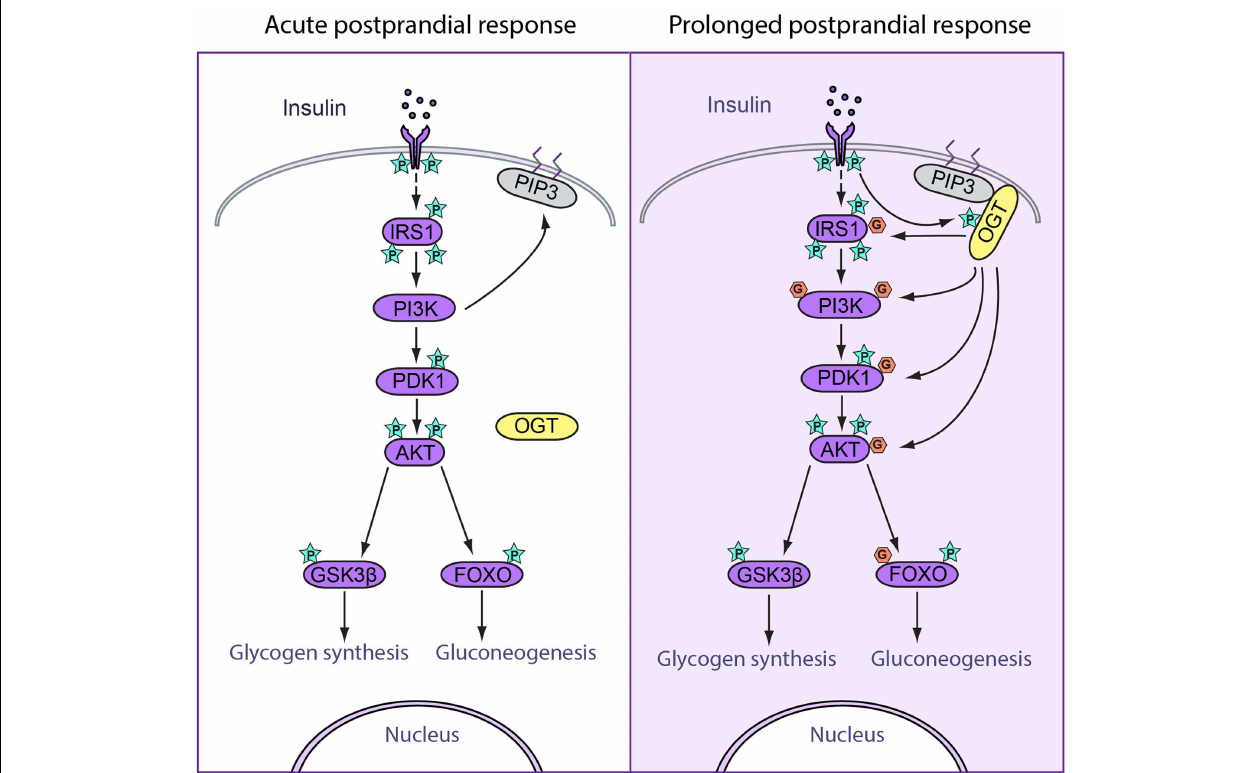
FIGURE 1 | Spatiotemporal regulation of feeding response by O -GlcNAcylation . (Left) Acute postprandial response. During early insulin signaling, OGT remains in the cytosol. Insulin binds to insulin receptor (IR) and triggers its autophosphorylation. Phosphorylation of IR recruits IRS1 to be phosphorylated, after which IRS1 binds to PI3K. PI3K catalyzes the production of PIP3, which recruits PDK1 to be phosphorylated and activated. Activated PDK1 phosphorylates and activates AKT, which further phosphorylates and activated downstream targets, including GSK3 β and FOXO, which enhances glycogen synthesis and suppresses gluconeogenesis. (Right)